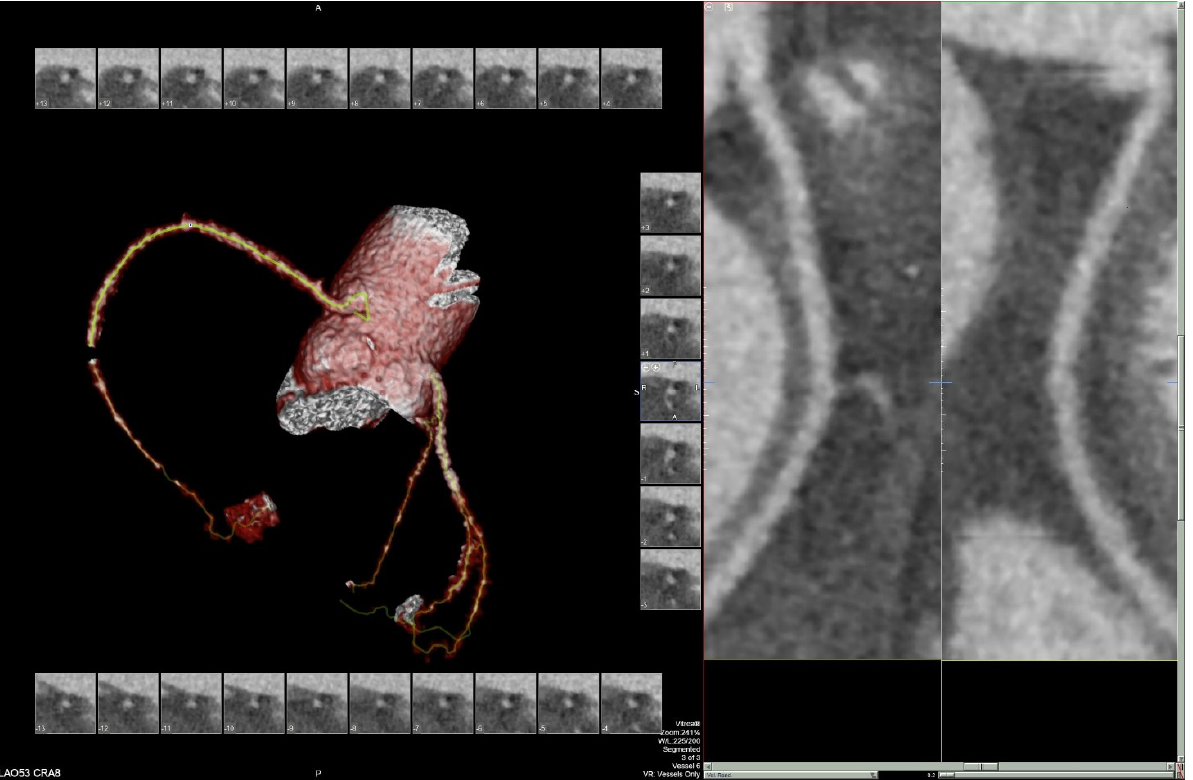
Figure 5. Segment of cardiac CT angiography demonstrating cardiomegaly and no coronary artery disease.